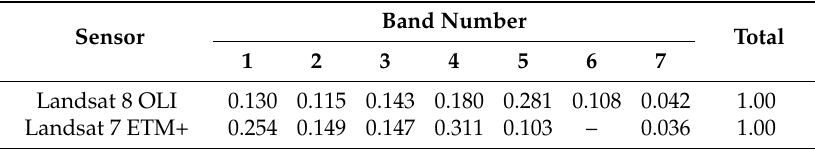
Table 4. Weighting coefficients based on at-surface solar radiation derived from